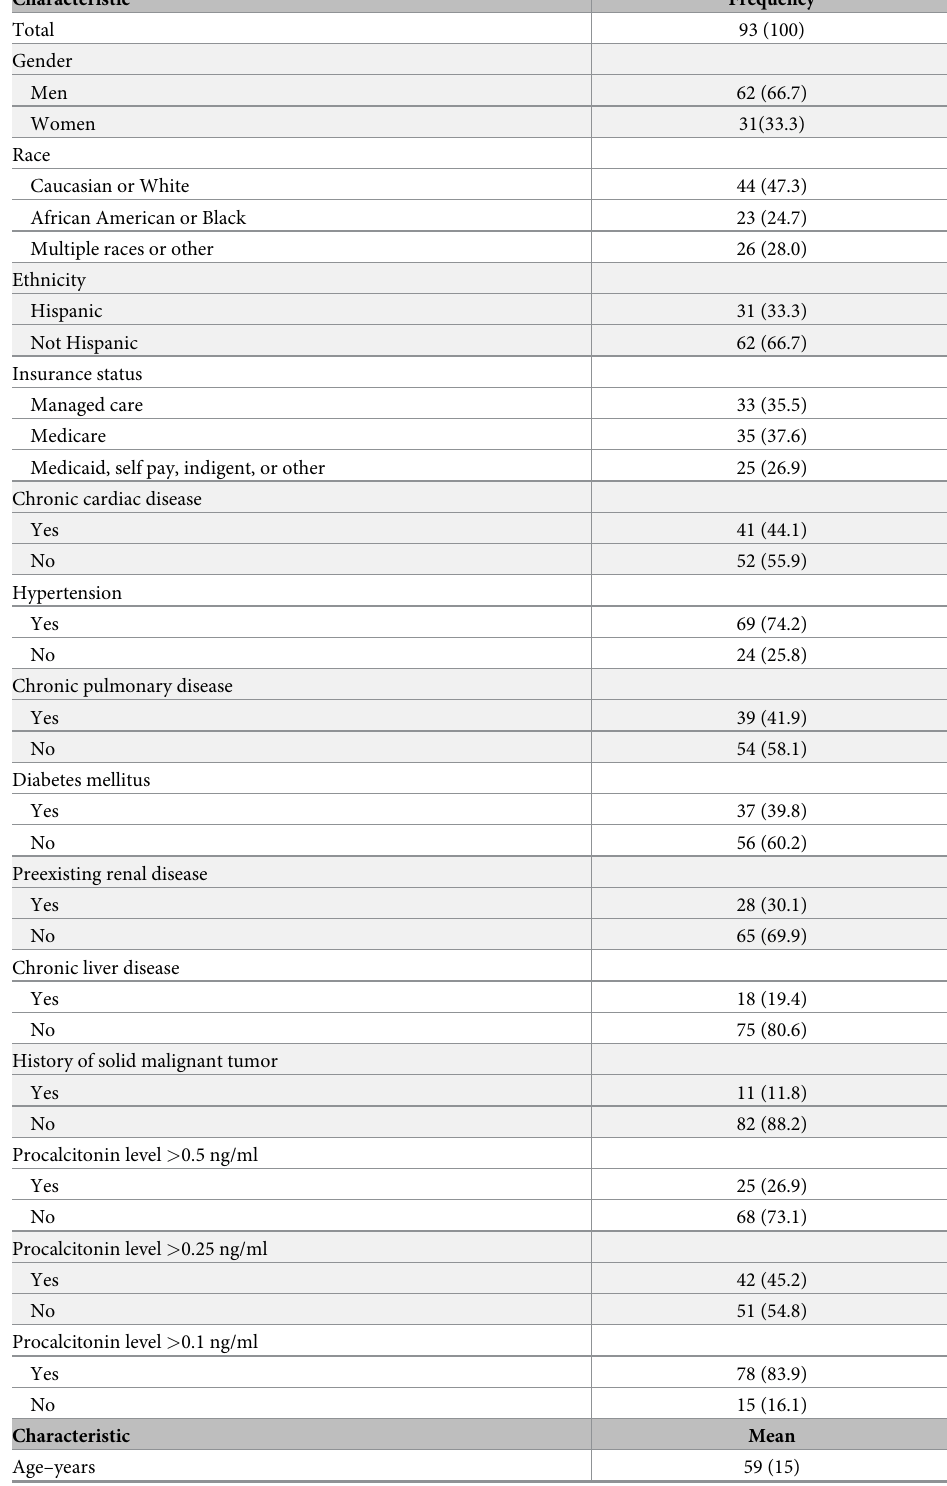
Table 1. Demographics, comorbidities, and